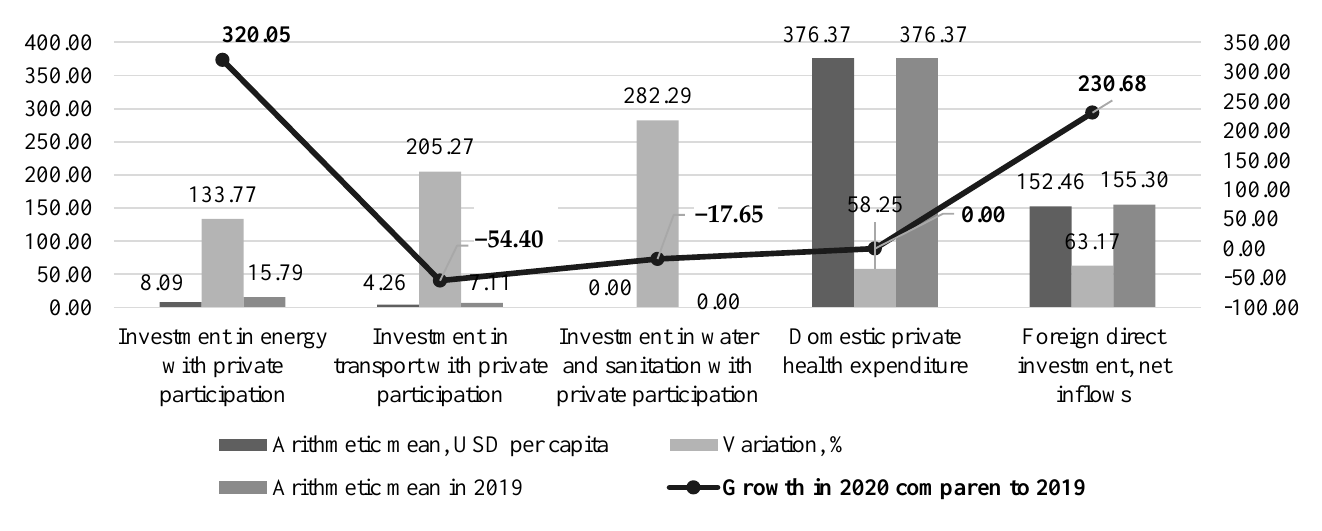
Figure 3. Investment flows in 2020. Source: authors.